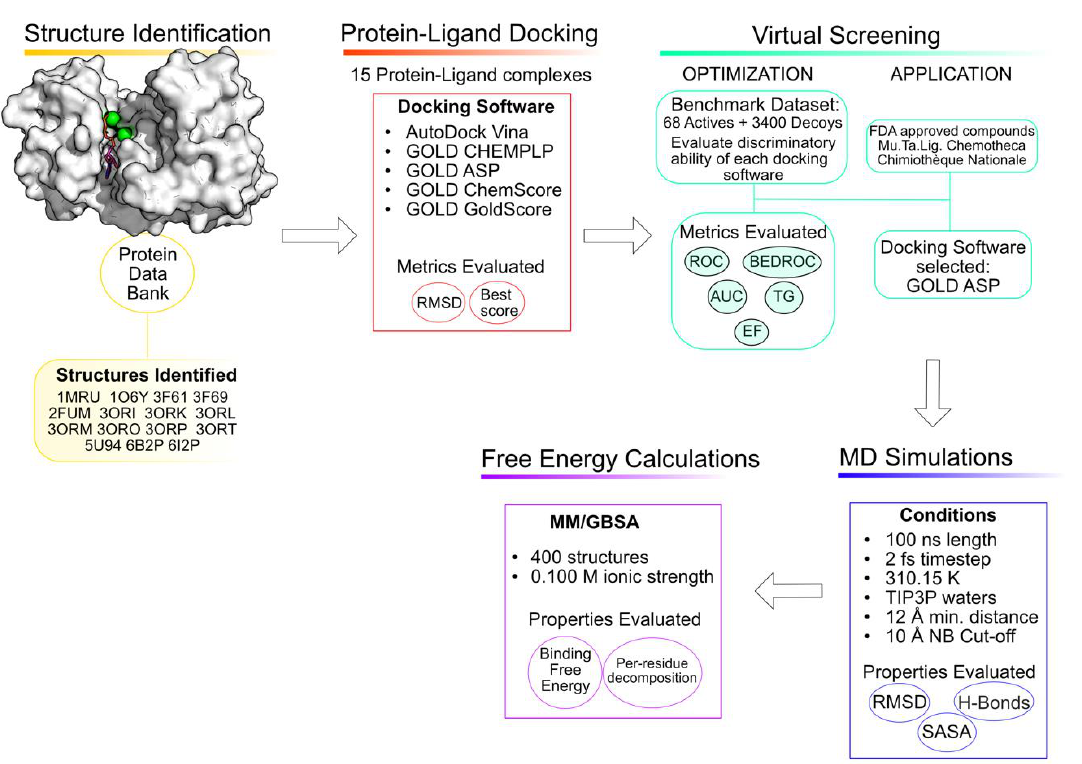
Figure 2. Workflow of the approach used in the current study.